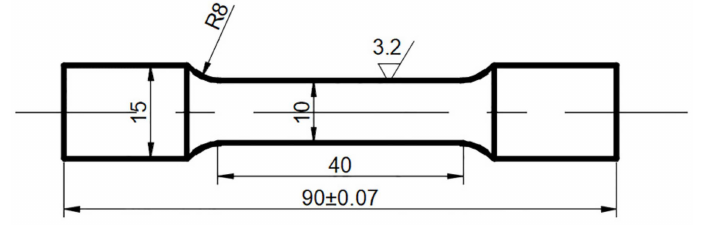
Figure 2. The schematic diagram of tensile